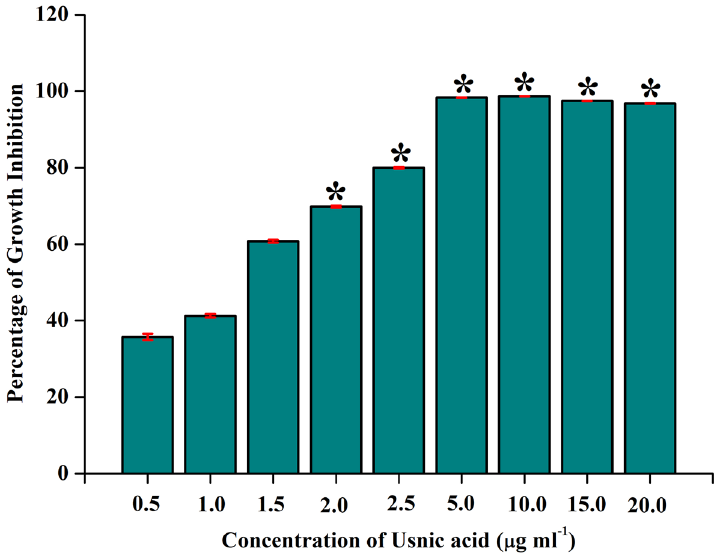
Figure 1. Impact of UA on growth of S. mutans. UA significantly inhibited the growth of S. mutans in a concentration dependent manner . At 5 µg mL −1 concentration, visible growth inhibition was observed and the same concentration was considered as MIC. Data are mean ± SD (n = 3) and Asterisk represent significant difference compared with the untreated control ( p <